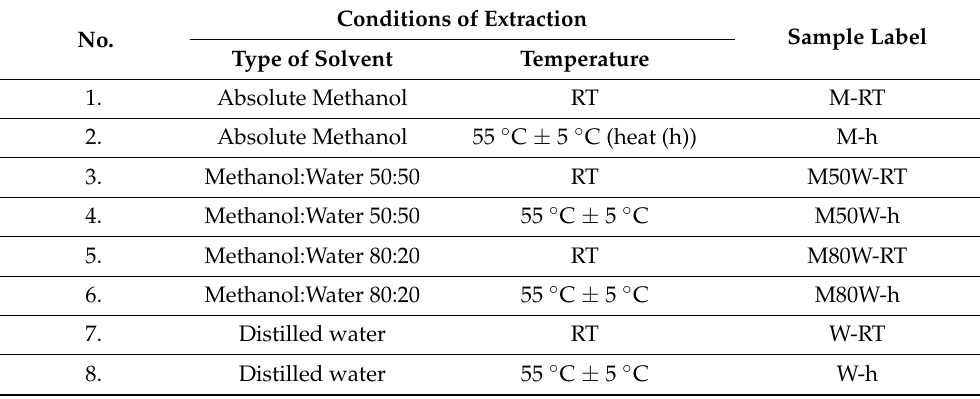
Table A1. Eight coffee samples were identified as follows: (sample labeling was abbreviated by using the initials of the solvent system in addition to the number of the higher ratio in the system (if any), dash, then the temperature condition applied (RT or h (for heating)). Conditions of Extraction Sample Label No. Type of Solvent